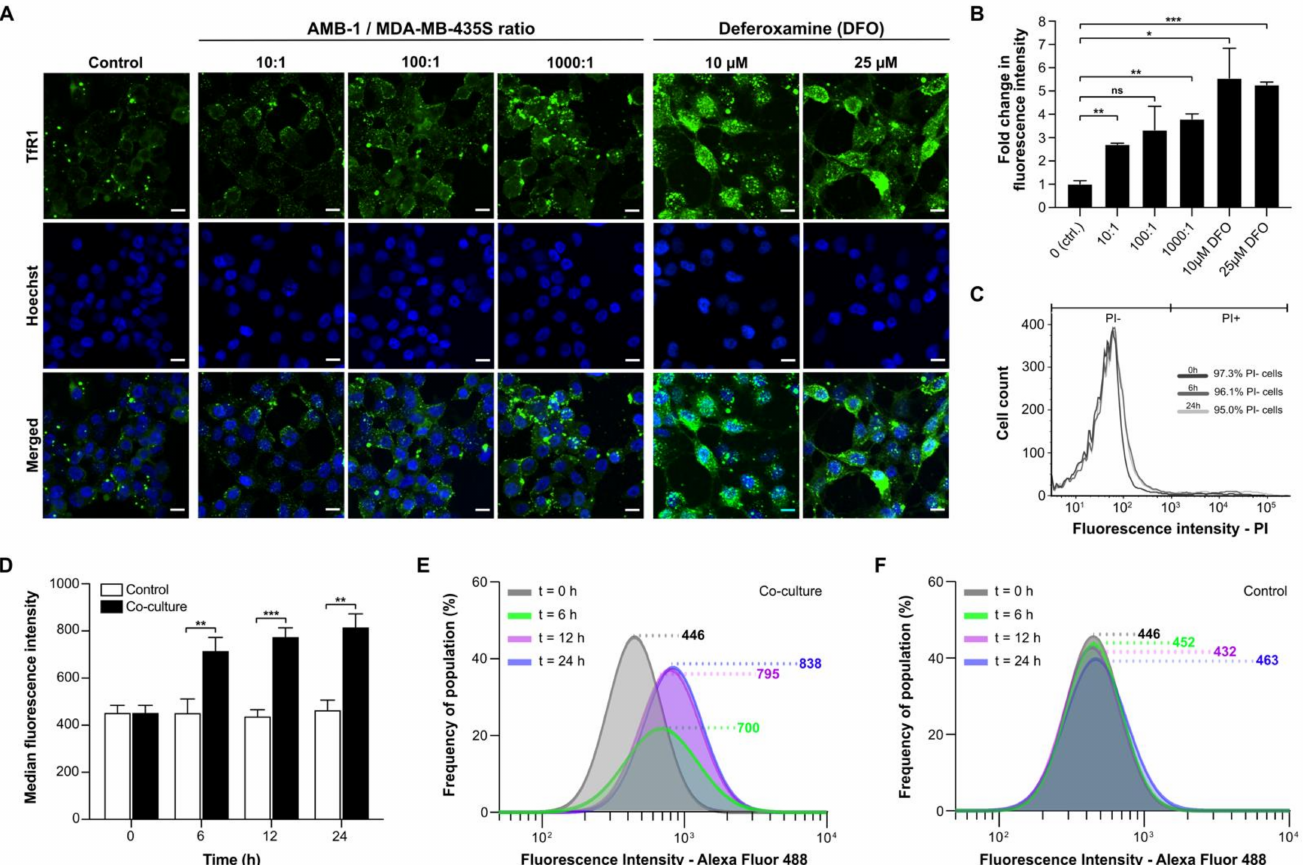
Figure 2. Analysis of transferrin receptor 1 (TfR1) upregulation and cell surface expression on MDA-MB-435S. ( A ) Represen- tative immunofluorescence images of human melanoma cells co-cultured under hypoxic conditions for 48 h with different ratios of AMB-1 bacteria and different concentrations of deferoxamine as a positive control. Images show MDA-MB-435S cells marked by anti-TfR1 antibody (green) and Hoechst 33342 (blue), scale bar: 10 µ M. ( B ) Graphical representation of the fluorescence intensities of the images shown in Figure 2A. Quantification of the fold changes in fluorescence were displayed relative to the control condition ( n = 2 biological replicates per condition, statistical significance was assessed with an unpaired two-tailed t -test, * p- value < 0.05, ** p- value < 0.01, and *** p- value < 0.001). ( C ) Membrane integrity was measured as a graphical representation of propidium iodide (PI)-negative and PI-positive cell populations after 0, 6, and 24 h. ( D ) TfR1 median fluorescence intensity measured over 24 h, ( n = 3 biological replicates per time point, statistical significance was assessed with an unpaired two-tailed t -test, ** p- value < 0.01, and *** p- value < 0.001). ( E ) Representative log-normal fitted fluorescence intensity histograms of cell surface TfR1 expression on MDA-MB-435S cells in co-culture model and ( F ) negative control, ( n = 3 biological replicates per time